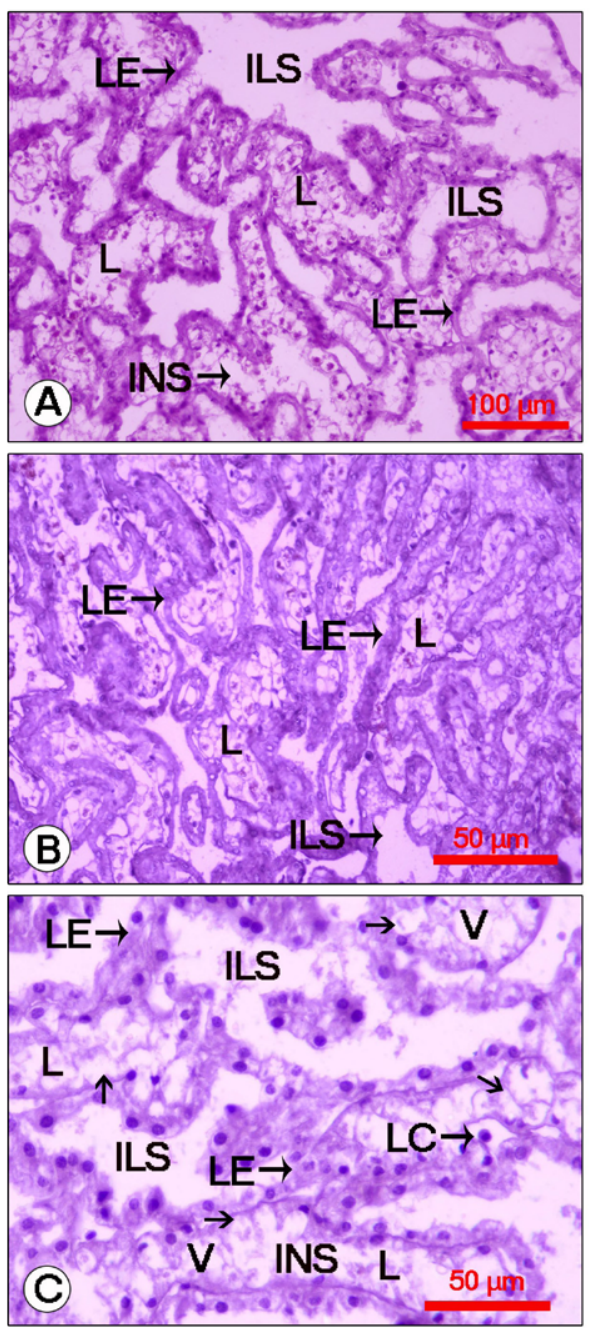
Figure 11. Light micrograph of Y-organ of crabs treated with 20E during early postmoult in Travancoriana schirnerae . ( A ) Medium sized branched lobules with a continuous lobular epithelium and reduced intra-lobular spaces. Note the prominent inter-lobular spaces. ( B ) Lobules compactly packed with cells. ( C ) Enlarged view of lobules with intact lobular epithelium and a few larger cells. ILS: Inter-lobular space; INS: Intra-lobular space; L: Lobule; LC: Larger cell; LE: Lobular epithelium; V: Vacuole; Arrow indicates cell degeneration.